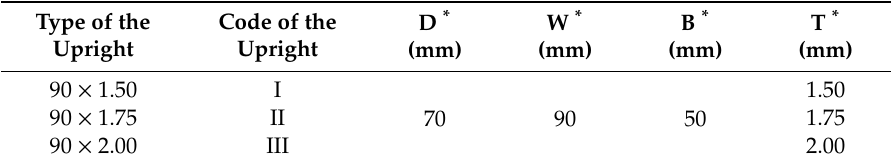
Figure 2. Cross section of the upright profile (dimensions D, W, b, t are given in Table 1). Table 1. Dimensions of the cross sections of the